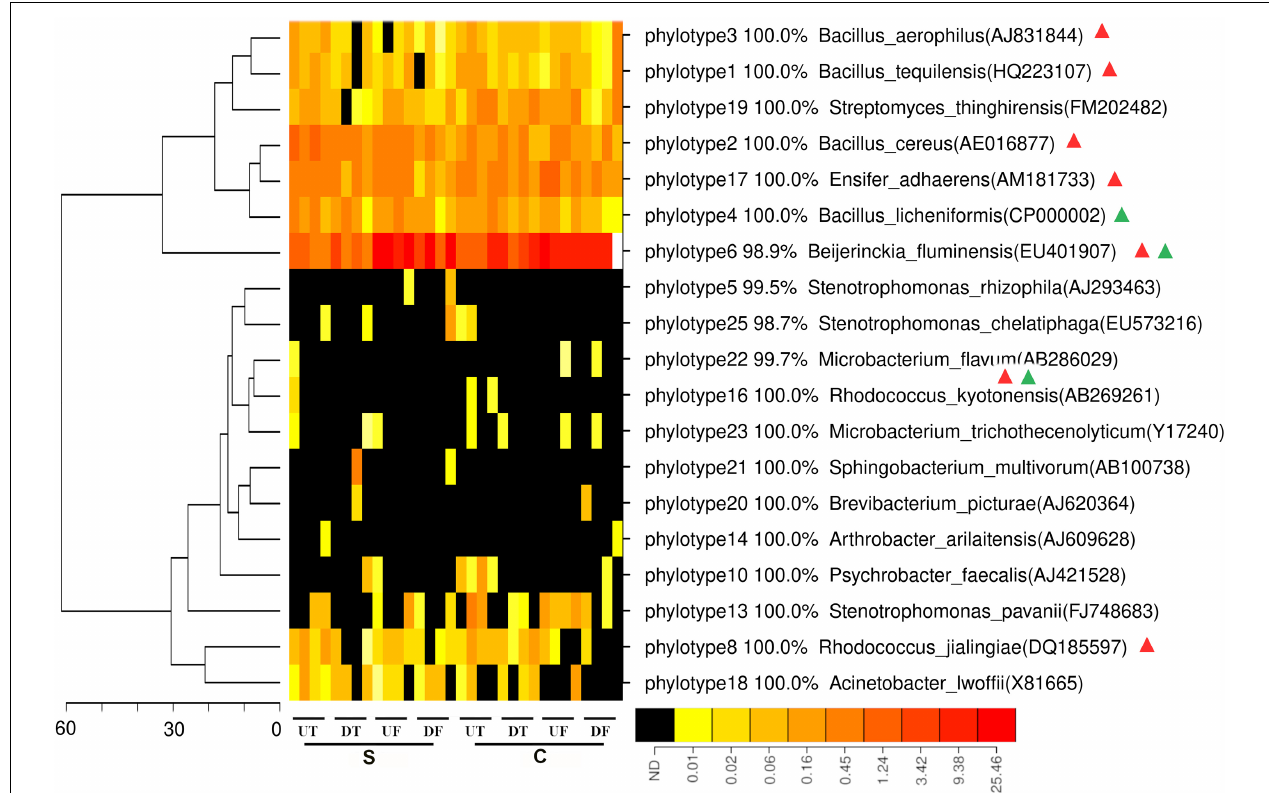
FIGURE 4 | Heatmap analysis of in vitro antagonist belonging to each phylotype in the rhizosphere of the upper (U) or lower (D) part of the taproot (T) or fibrous (F) roots treated by the disease-suppressive (S) or non-suppressive soil (C). Those phylotypes with significantly different relative abundance at four parts of roots are indicated by green or red triangle for the disease-suppressive or non-suppressive soil, respectively. The minus symbol indicates decreased relative abundance in the suppressive soil. Phylotype that significantly differed at relative abundance in the rhizosphere of different root parts under suppressive or non-suppressive soil is indicated by red or green triangle,